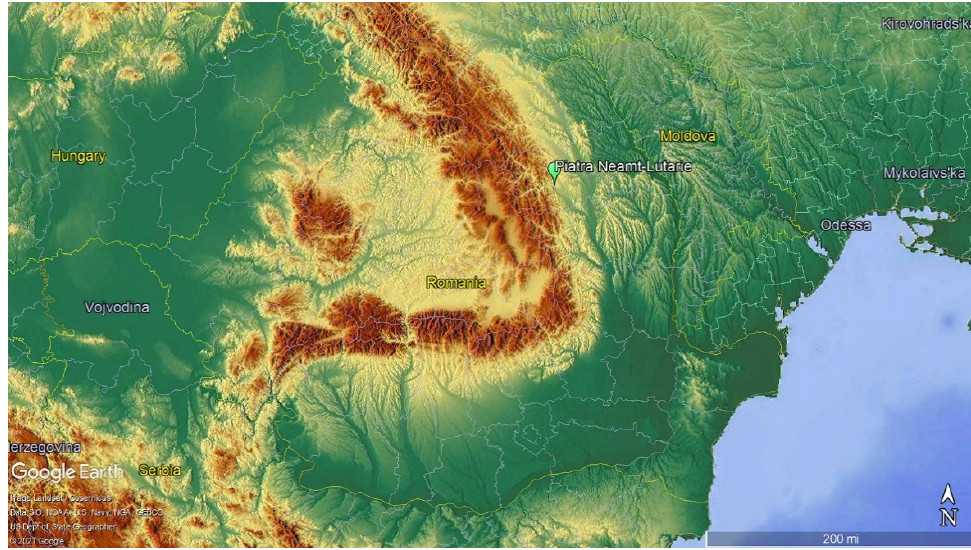
Figure 1. Geographical location of the Piatra Neam ț – Lut ă rie settlement. Geologically, the site area is located on Paleogene deposits (Oligocene), consisting of clays, breccias, sandstone and conglomerates. In the western part of the site, represented by the Pietricica peak, Paleogene deposits are composed of sandstone-shale flysch, bituminous flysch with Kliwa sandstones, and conglomerates. To the east, the area is made up of Quaternary formations (Pleistocene) consisting of sands, gravels, boulders and loess deposits [11]. Pedologically, in the settlement area and in its vicinity, there are only chernozems [12]. Therefore, the settlement from Piatra Neam ț – Lut ă rie is located in a geological area rich in raw clay materials that could be used in pottery making and fertile soils used in agricultural